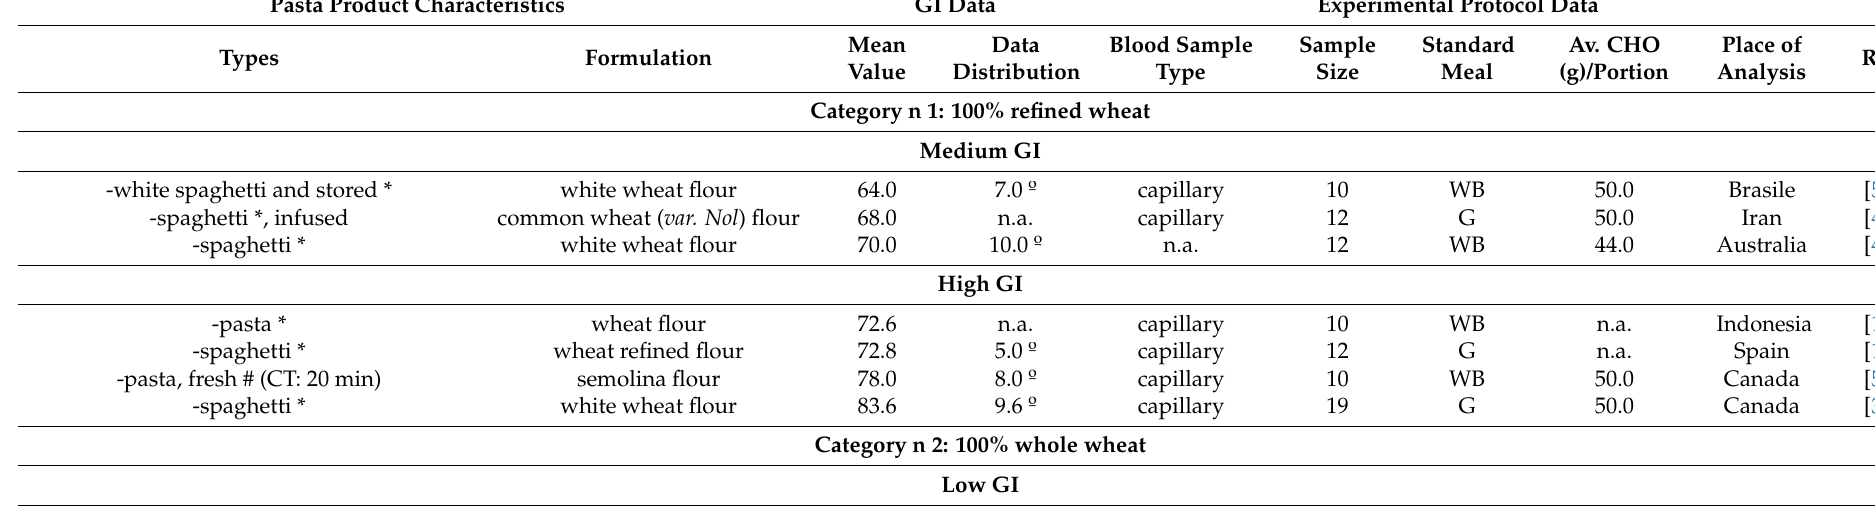
Table 1. Pasta product characteristics, glycemic index and experimental protocol data. Pasta Product Characteristics